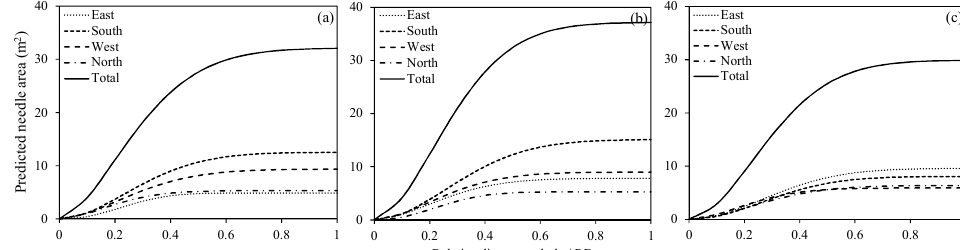
Figure 8. Cumulative horizontal distribution of the predicted NA according to the RD at intervals of